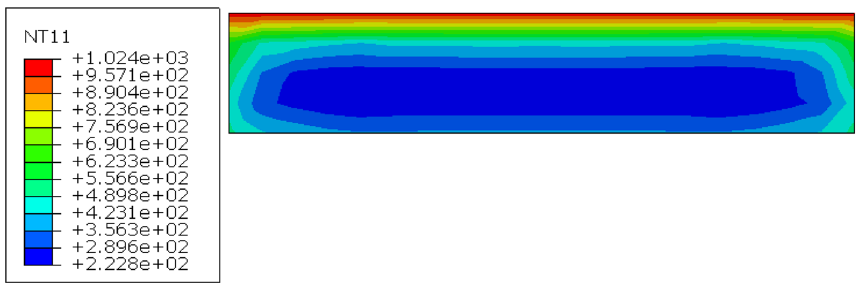
Fig. 35 Temperature distributions across the cross section of shear